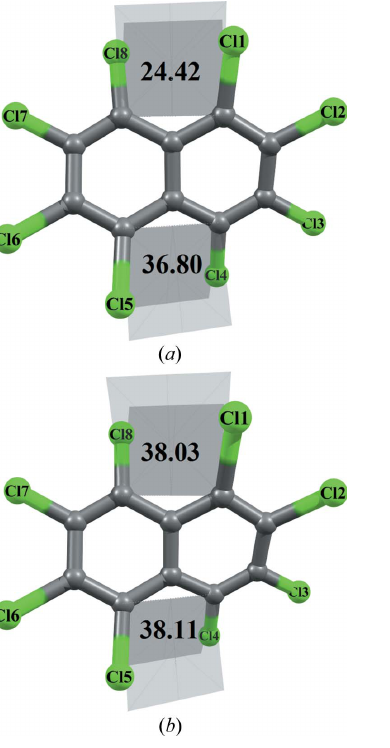
Figure 6 ( a ) Geometry of OCN in the crystalline state. ( b ) Geometry of OCN in the solvated optimized